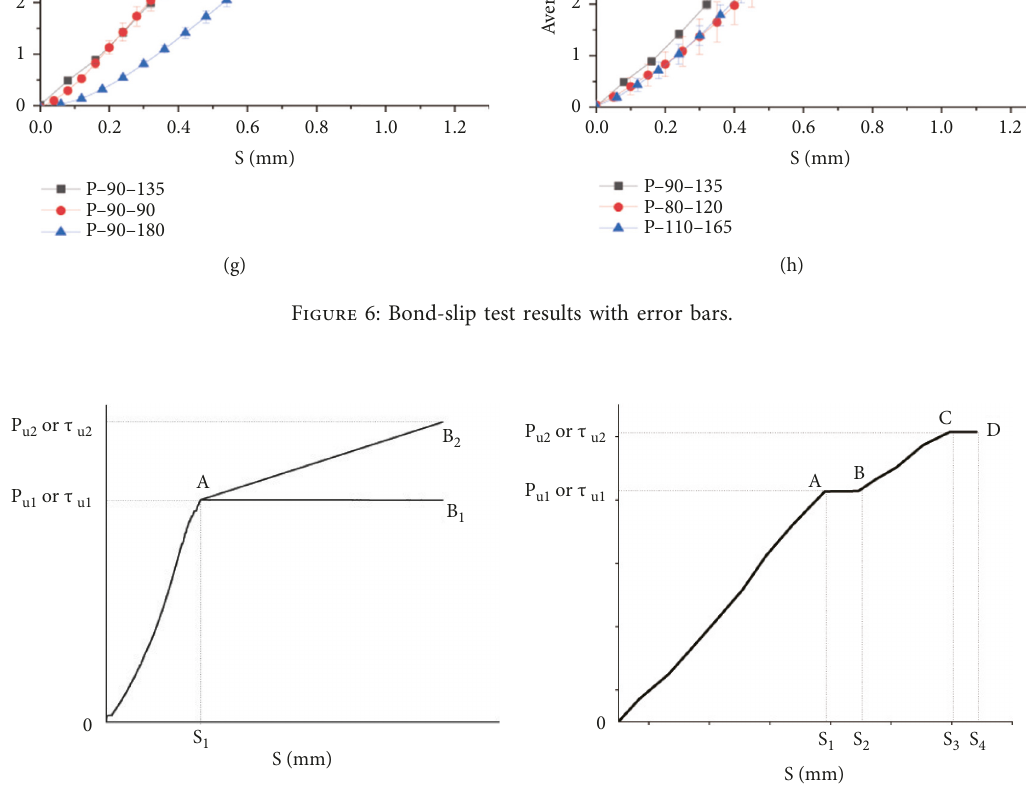
Figure 7: Curve types. (a) Type I curve, (b) Type II